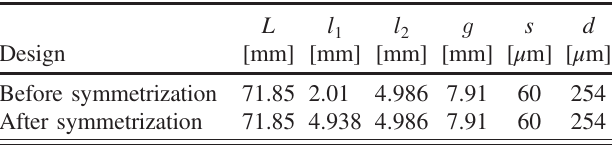
TABLE V. Allison scanner geometries at FRIB front end, before and after modification in Feb 2018.